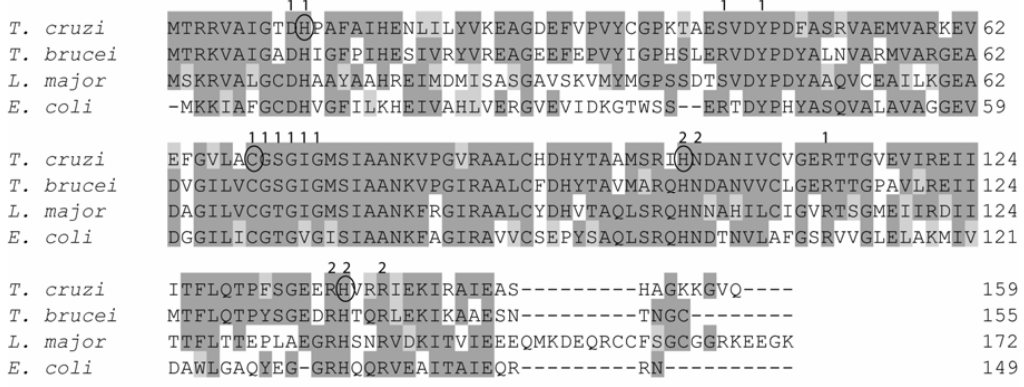
Fig. 5 – Alignment of the deduced amino acid sequences of different ribose 5-phosphate isomerases. The TcRPIB (gi: 110984574) is aligned with those of T. brucei (gi:70834348), L. major (gi:68127548) and E. coli (gi: 85676843 W3110). Mutagenizated aminoacid residues are circled. Residues that lie within the RPI active-site pocket are annotated with 1 for one subunit and with 2 for the second.